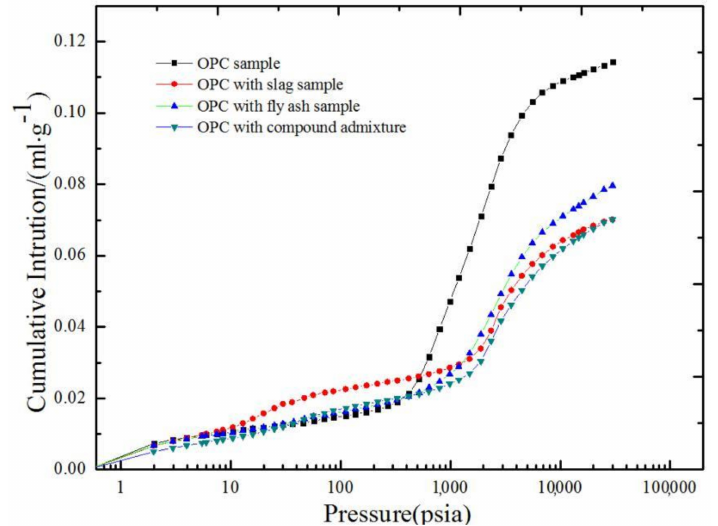
Figure 5. MIP curves of relationship between pressure and cumulative